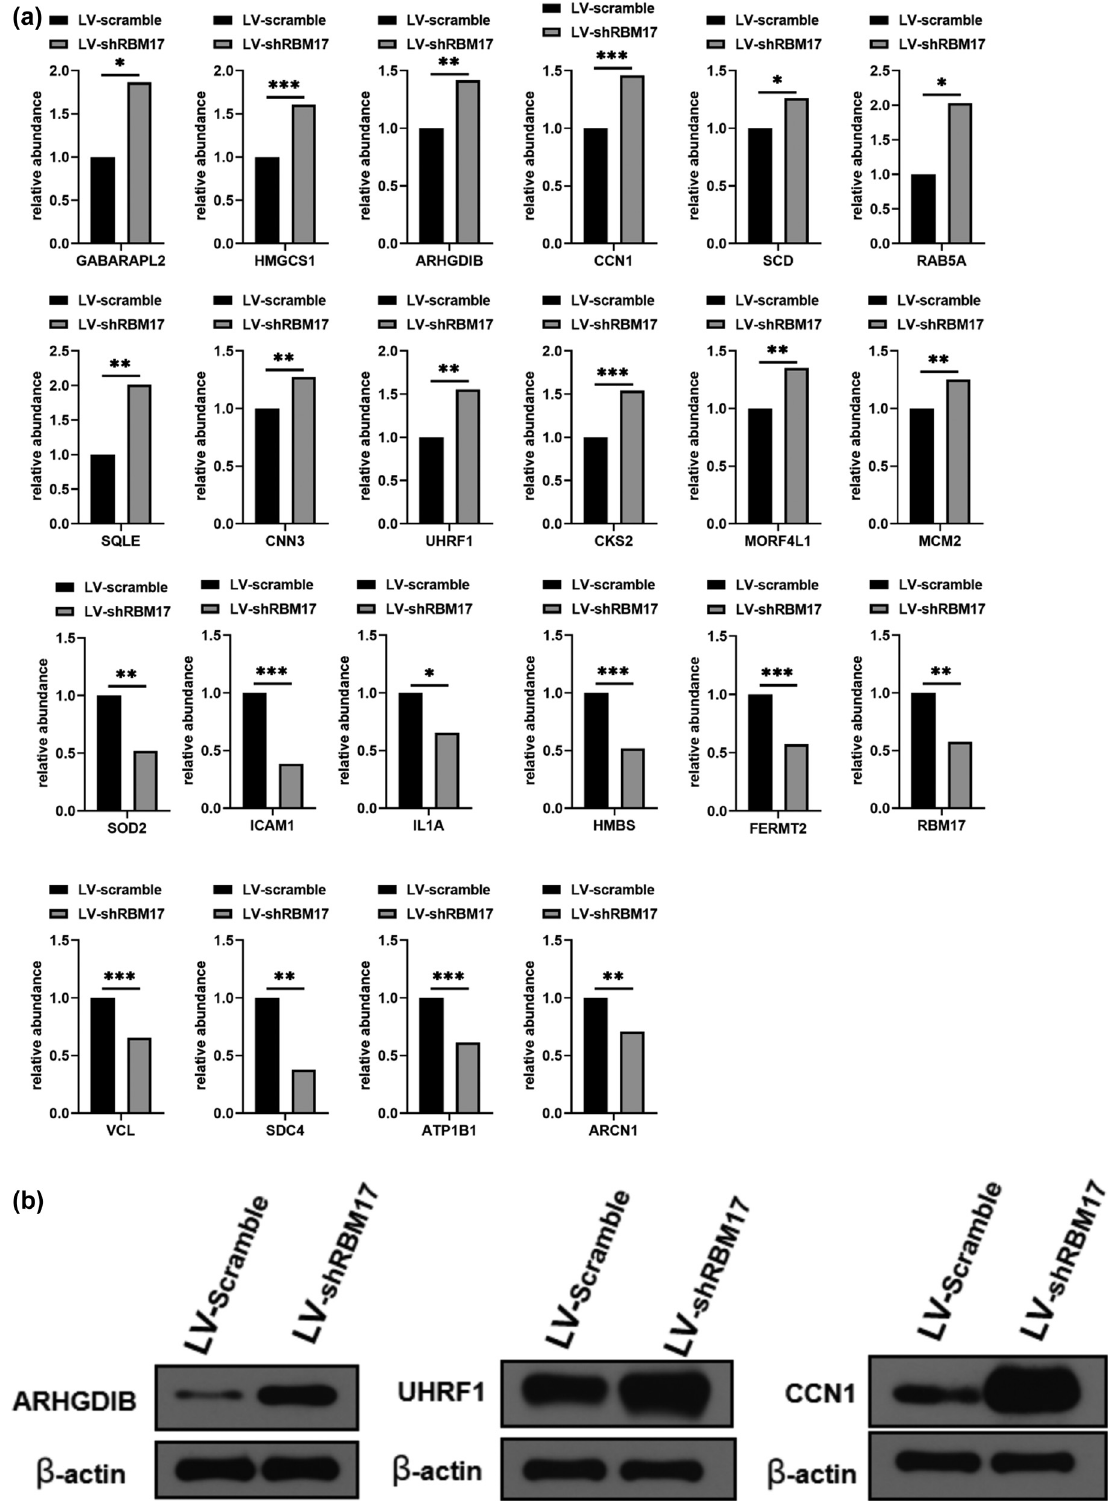
Figure 6: PRM analysis of the di ff erentially expressed proteins. ( a ) PRM analysis of the di ff erentially expressed proteins after down - regulation of RBM17 compared to LV - scramble groups. ( b ) Selected di ff erentially expressed proteins were con fi rmed by western